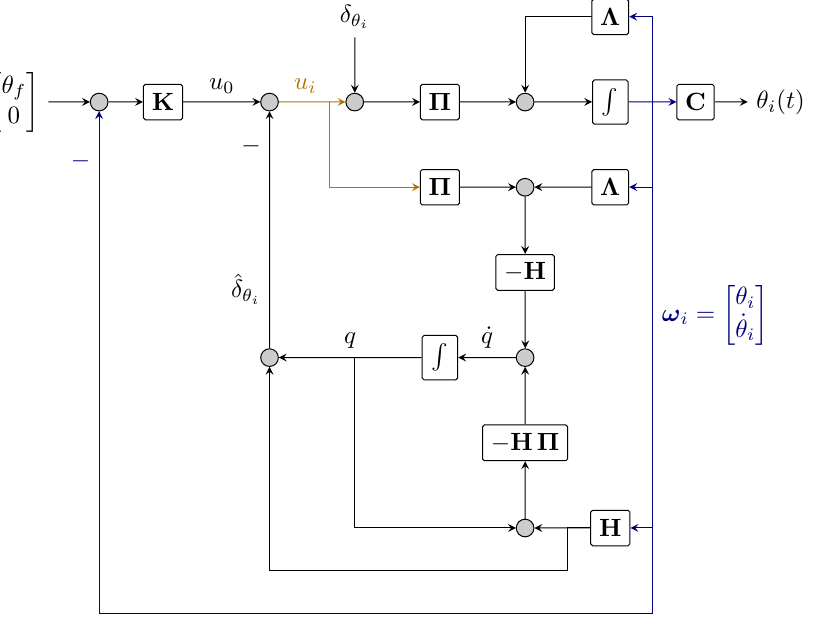
Figure 3. Disturbance observer for agent i